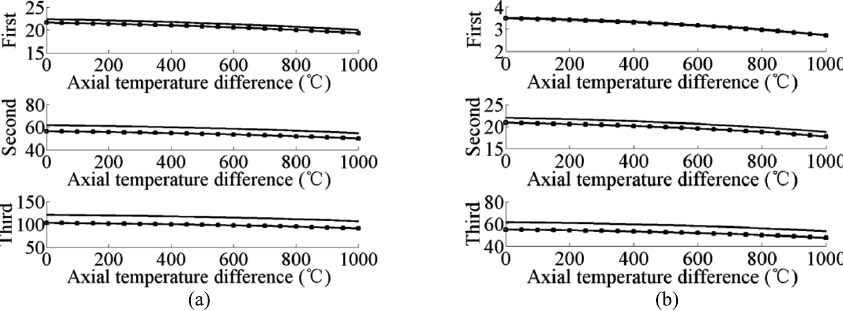
Fig. 13. Variation of the first three dimensionless natural frequencies with the maximum axial temperature difference of a beam under linearly varying axial temperature distribution: (a) free-free boundary condition, (b) free-clamped boundary condition. “Unmarked” curves relate to results of Euler-Bernoulli beam, “marked” curves relate to the results of Timoshenko beam.